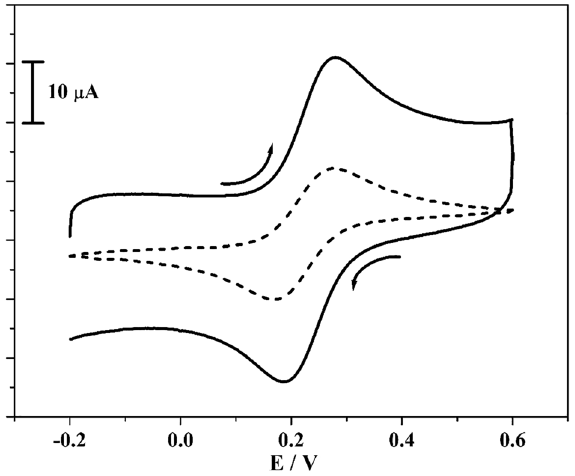
Figure 2. CVs curve recorded for 1 mM K 4 [Fe(CN) 6 ] at unmodified (scattered streak) and poly (CBBG)/MCPE (hard streak) with sweep rate of 0.05 Vs −1 using 1 M KCl (supportive electrolyte).